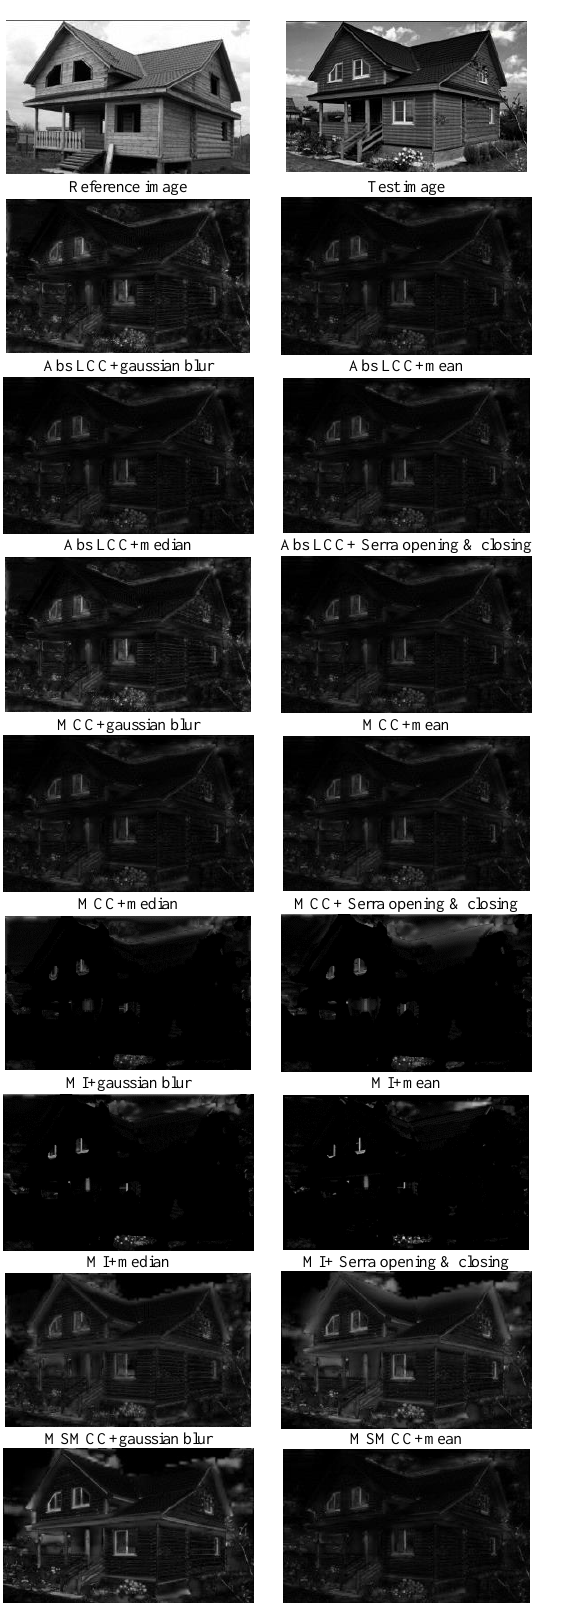
Figure 3. Example of morphological difference maps based on guided contrasting with various combinations of LSC and SO (building construction)